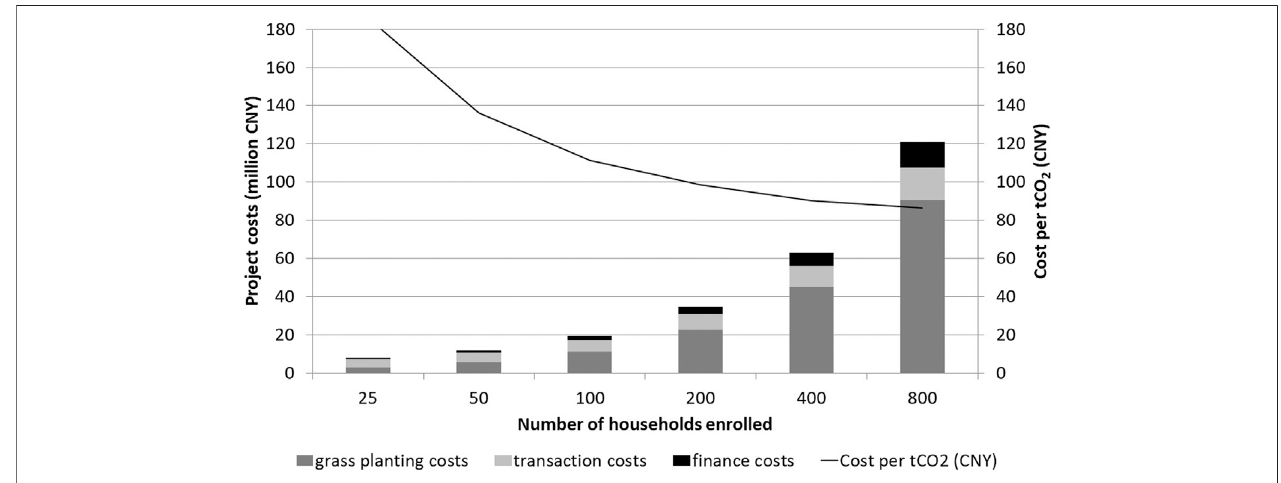
FIGURE 4 | Structure of project developers ’ costs and cost per tCO 2 at different scales of implementation of a carbon fi nance project (Chinese Yuan,